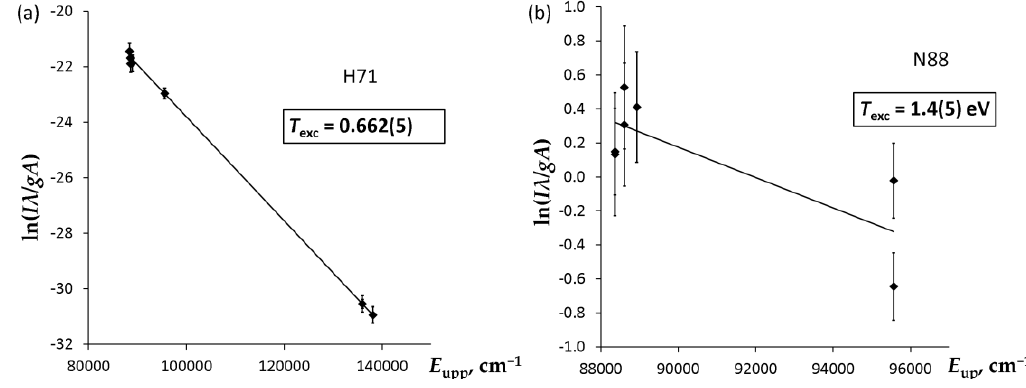
Figure 4. Boltzmann plots for relative intensities of observed lines: ( a ) Measurements of Hefferlin et al. [47] (H71); ( b ) Measurements of Neger and Jäger [49] (N88). The A -values used in these plots are the final adopted values given in Table A1. The error bars are combined uncertainties of A -values and relative intensities (see text).